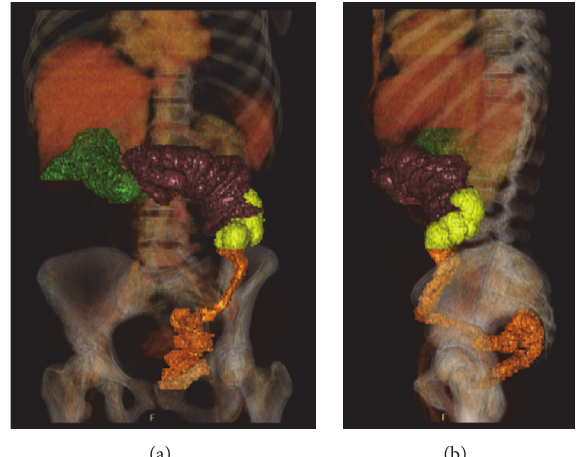
Figure 3: Contrast-enhanced CT, portal venous phase, 3D volume rendering reconstructions. The anatomical structures of interest were segmented for a panoramic view: the dilated last ileal loop (green), the intussuscepted colonic segments (purple-brown), the lipoma (yellow), the collapsed distal third of the left colon, and the sigmoid and rectum (orange). The skeletal structures and the parenchymatous organs were left in